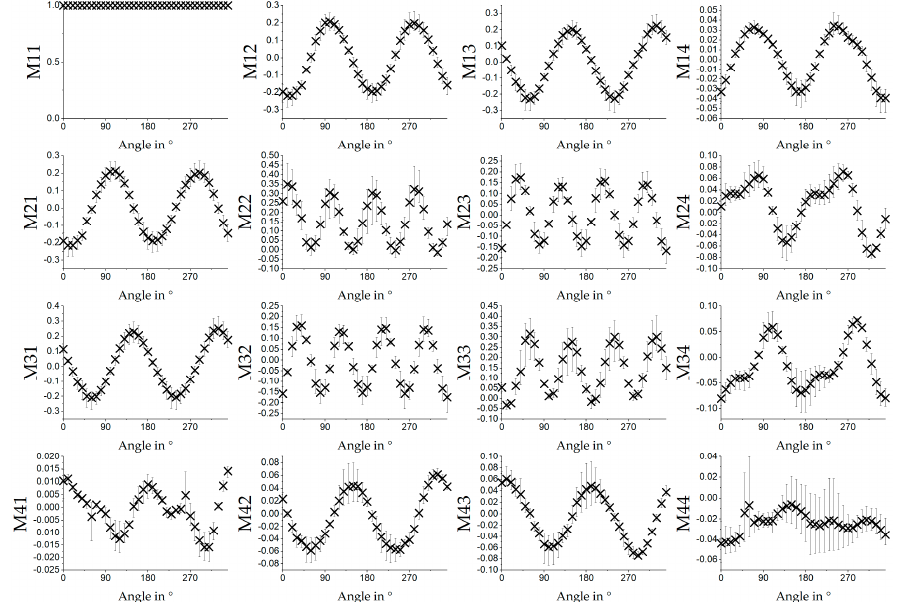
Figure 6. Average values of the MM images for relative collector velocity 8.3 m/s ( n = 3; error bars: min. and max.) for different angles of the sample measured in transmission with 532 nm. The fibres are oriented horizontally at 0°.